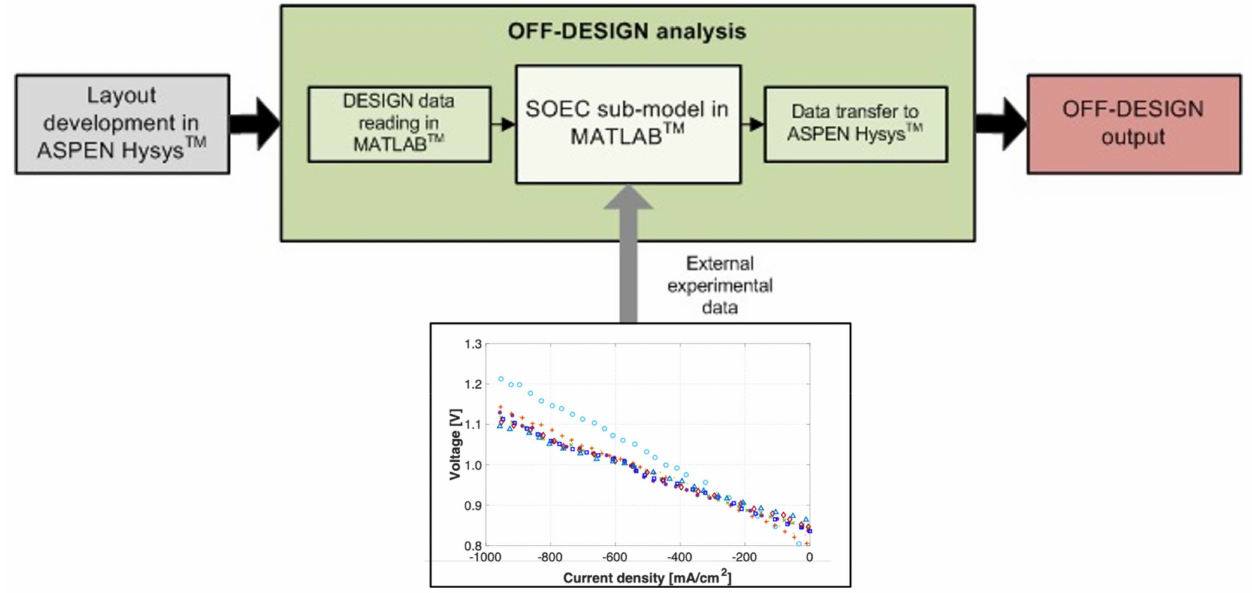
Figure 2. Simplified block diagram of the numerical model developed in an integrated tool environ- ment (figure elaborated using data by [14]).